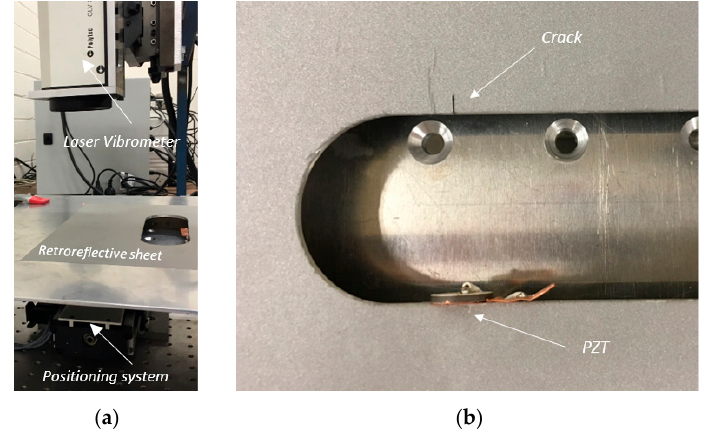
Figure 3 . ( a ) Laser vibrometry setup showing a 450 mm × 450 mm × 3 mm aluminium plate with